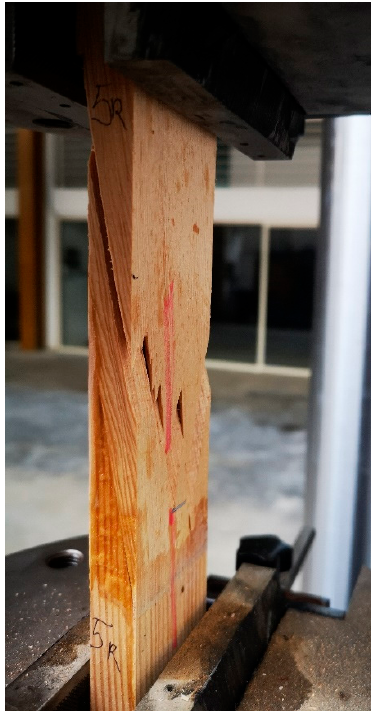
Figure 4. Scarf-joint after rupture.